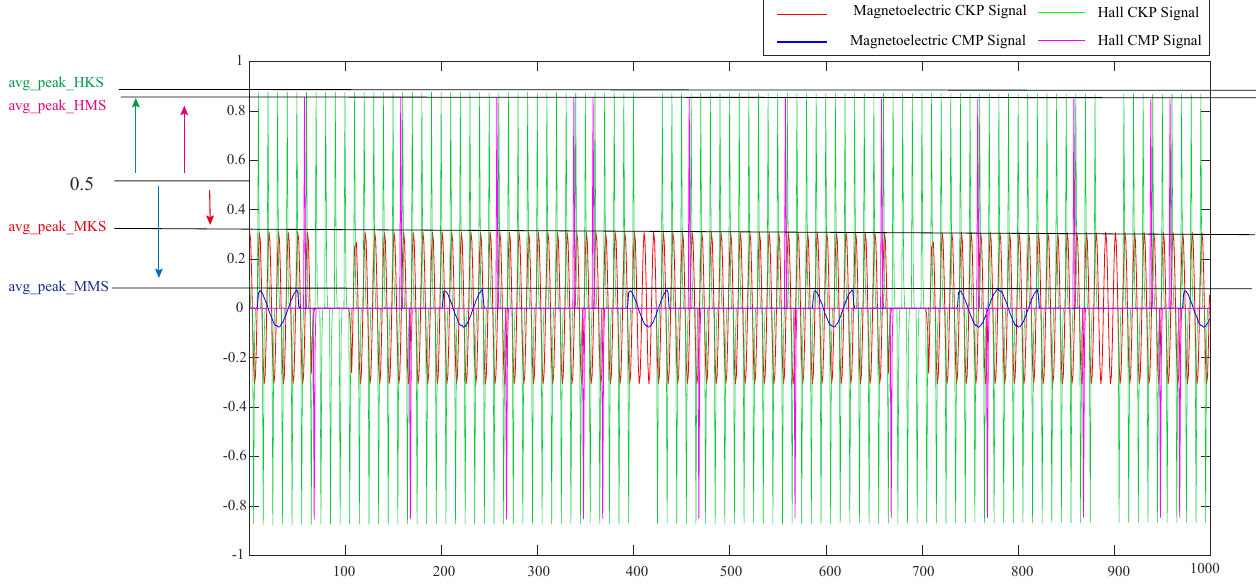
Figure 4. The adjacent point difference diagram. avg_peak_HKS, avg_peak_HMS, avg_peak_MKS, and avg_peak_MKS represent the mean values of signal peaks